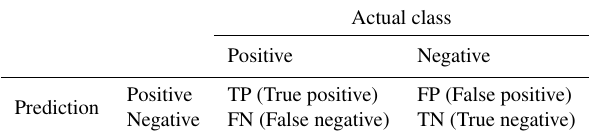
Table 4. Confusion